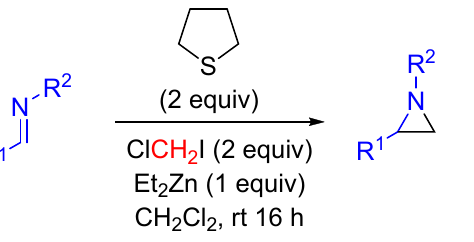
Scheme 28. Simmons–Smith carbenoid method for generation of sulfonium ylide.